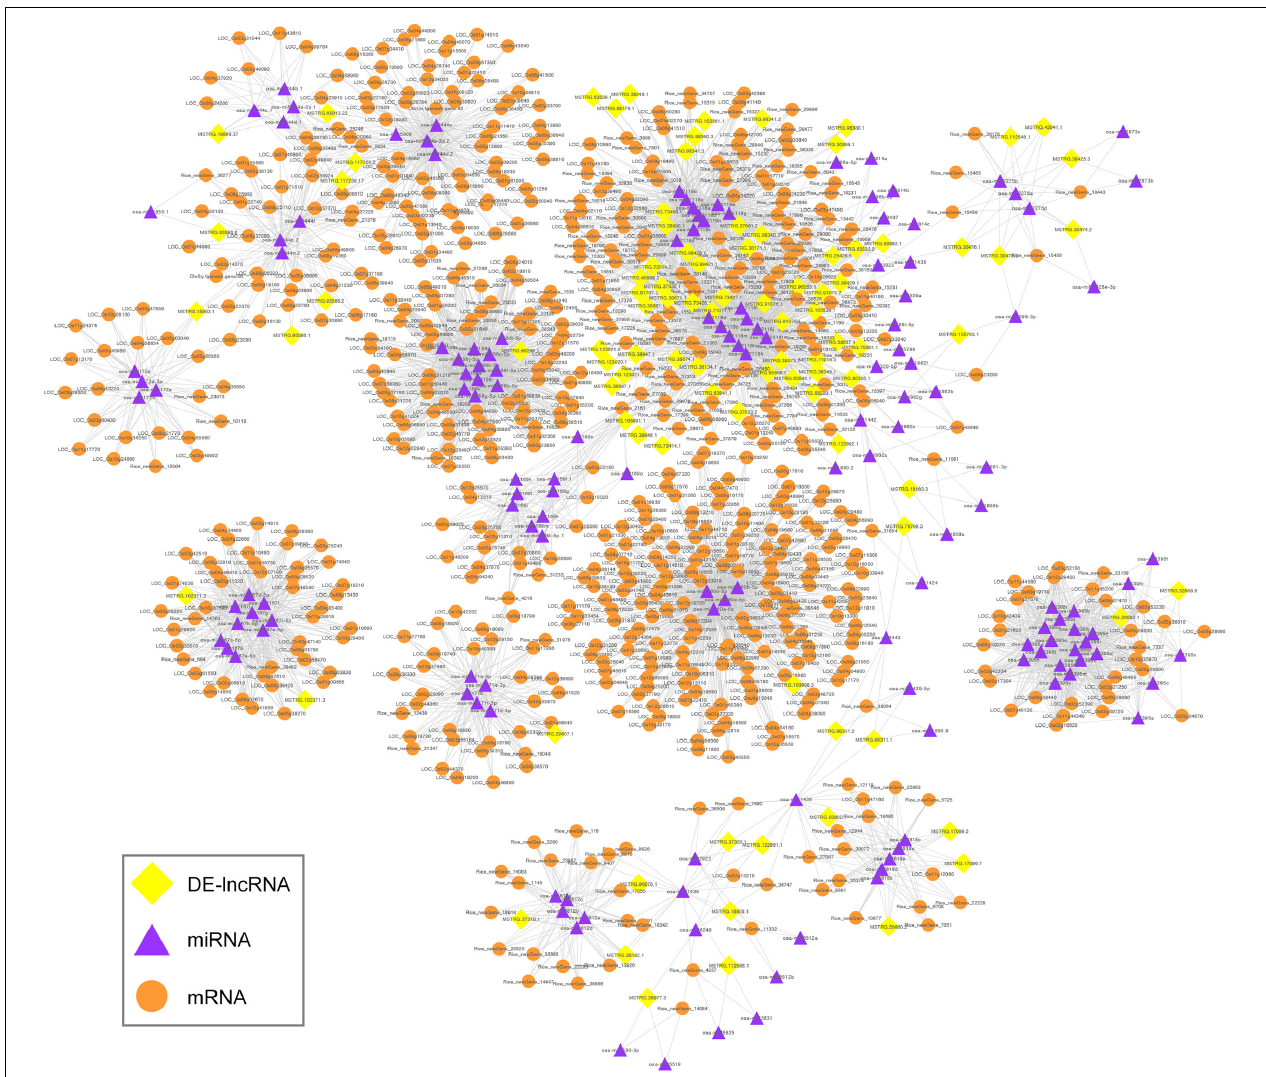
FIGURE 8 | Global ceRNA networks in the PTGMS rice line. The yellow diamond-shaped, purple triangular, and orange round nodes represent DE-lncRNAs, miRNAs, and mRNAs,